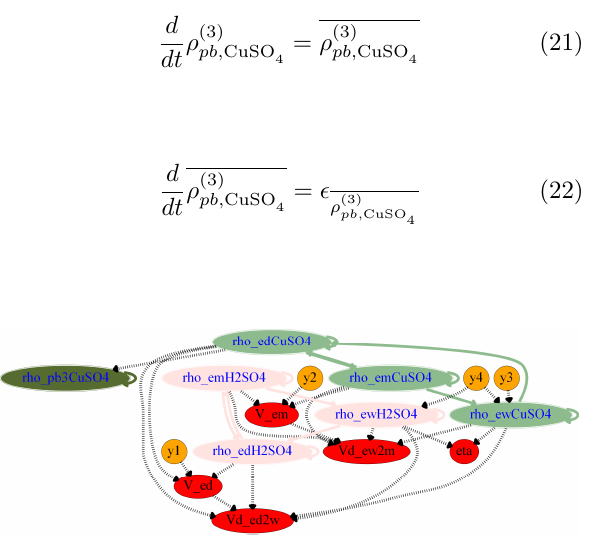
Figure 4: System digraph for the electrowinning section.